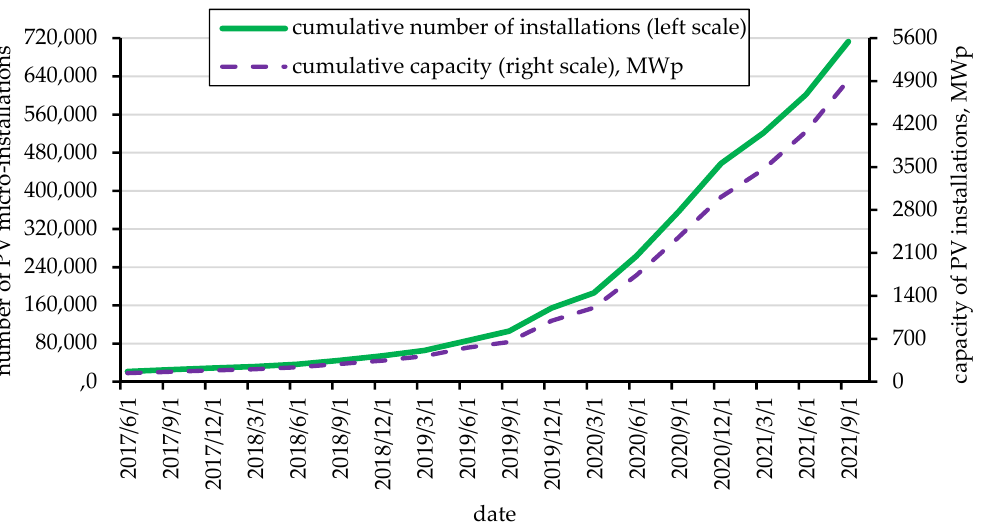
Figure 3. Number of PV micro-installations and PV installed capacity in Poland. Source: own study based on [30].